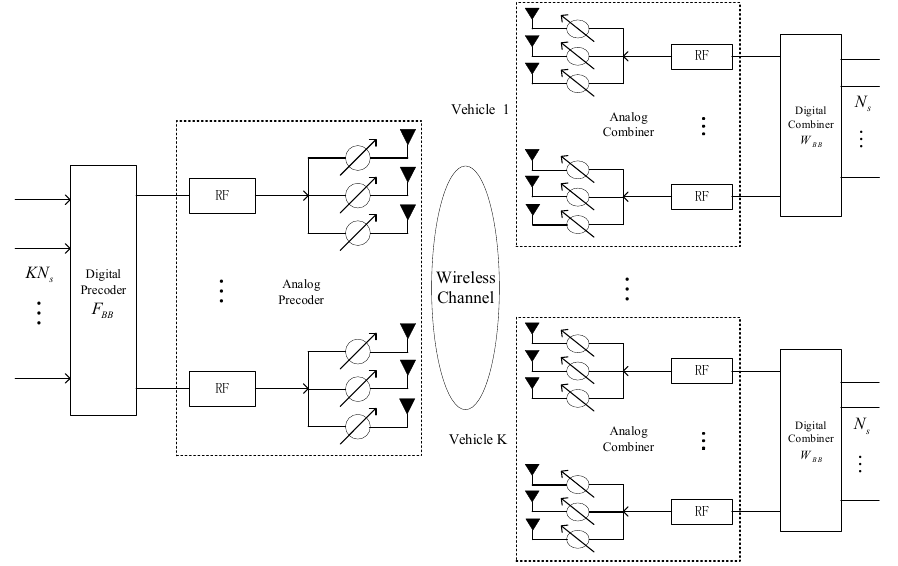
Figure 1. Adopted dynamic hybrid precoding structure.